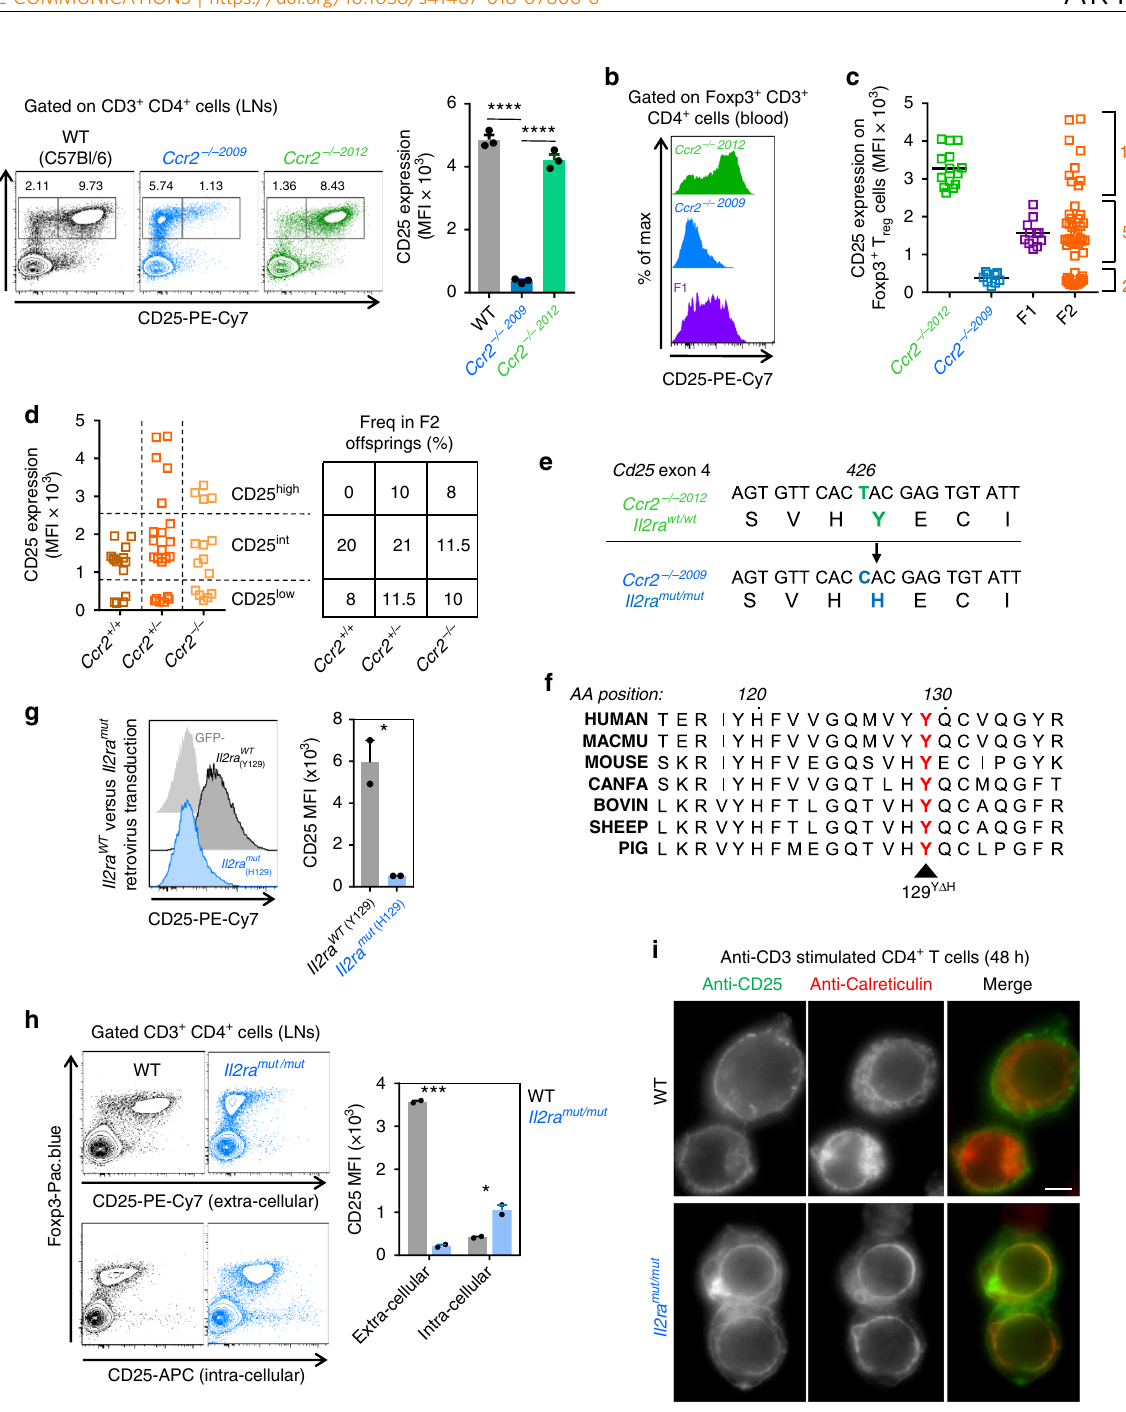
Fig. 1i). CD25 subcellular localization in anti-CD3-stimulated CD4 + T cells from either Il2ra mut/mut or WT mice, suggested that mutant CD25 mostly co-localized with calreticulin, an endoplas- mic reticulum (ER) resident protein. A strong staining of the nuclear envelope, a subdomain of the ER, was observed in Il2ra mut/mut but not WT CD4 + T cells, suggesting that the Y129H mutation prevented proper folding of CD25 and subsequent egress from the ER to the cell surface (Fig. 1i). Thus, we isolated and characterized a mouse mutant line with a point mutation in an evolutionarily highly conserved tyrosine of the high af fi nity IL- 2 receptor alpha chain CD25, likely preventing its optimal folding and subsequent cell-surface